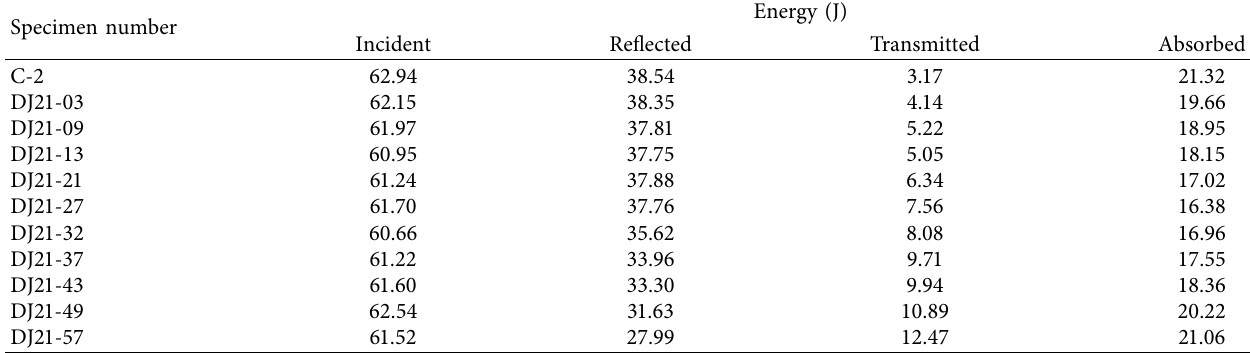
Table 2: Energy data of rock-concrete composite specimens with different thickness